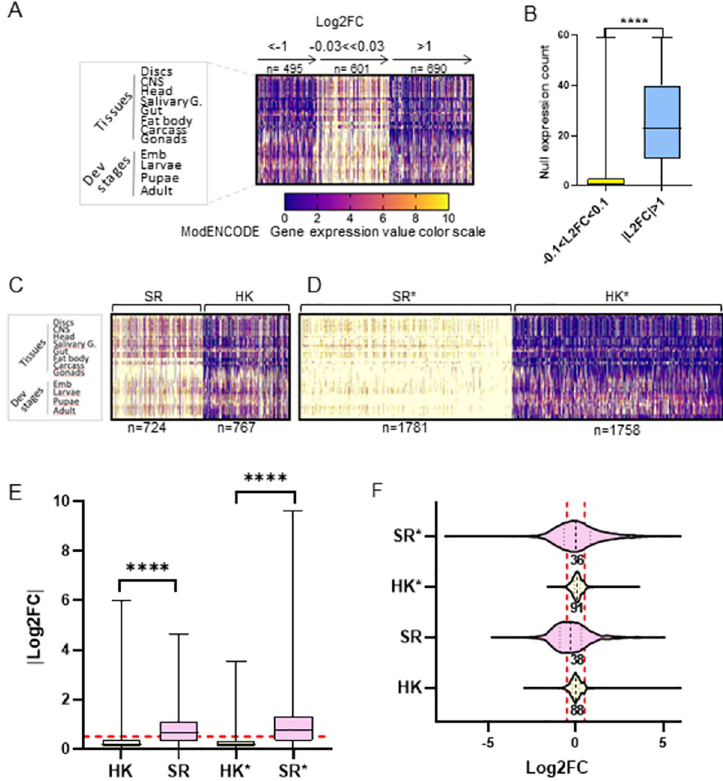
Fig 3. Spatially and temporally regulated genes are more prone to expression change than constitutively expressed genes upon Med19 AID depletion. (A) Heat map depicting the spatio temporal expression profiles (modENCODE) of genes belonging to three different ranges of expression fold change (L2FC specified above the horizontal axis) in our transcriptomic analysis. Each column contains the color-coded expression score (modENCODE) of a gene in 58 different tissues and developmental stages (left panel and S2 Table for details) extracted from the modENCODE Drosophila gene expression database the expression profiles of each gene we found expressed in the wing imaginal disc, compiling expression scores in 58 different developmental stages and tissues. (B) Box plot analyzing the count of the number of null expression (0 and 1 expression score occurrences) among the 58 expression values for the genes belonging to |L2FC| > 1 (n = 1185) or -0.1 < L2FC < 0.1 (n = 1704) range. Median significantly different P < 0.0001 two- tailed non-parametric Mann Whitney test. (C) Gene expression profile heat maps as in (A) comparing the expression profiles of published sets of housekeeping genes (HK, n = 767) and spatially regulated genes (SR, n = 724); lists in S4 Table. (D) Heat maps as in (C) showing the expression profiles of the HK � and SR � sets of genes obtained by selecting HK and SR-like expression profiles from the modENCODE expression scores matrix (see materials and methods, lists in S4 Table). (E) Box plot comparing the Log2FC absolute values of the sets of genes specified on the x axis, and whose expression profile is shown above. ���� : Median significantly different P < 0.0001 two-tailed non-parametric Mann Whitney test. The red dashed line marks |Log2FC| = 0.5. (F) Violin plot showing the distribution of the expression Log2FC values of the sets of genes mentioned on the vertical axis (analyzed in the Fig 2E). The percentage of genes in the -0.5 < Log2FC < 0.5 range, delimited by the two red dashed vertical lines, is indicated below the violin